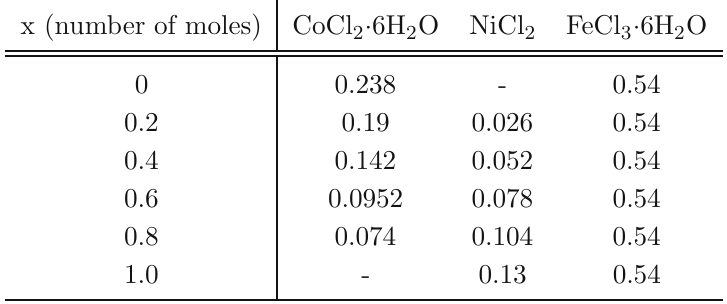
Table 1 Experimental conditions (in g) for the synthesis of Ni x Co 1 − x Fe 2 O 4